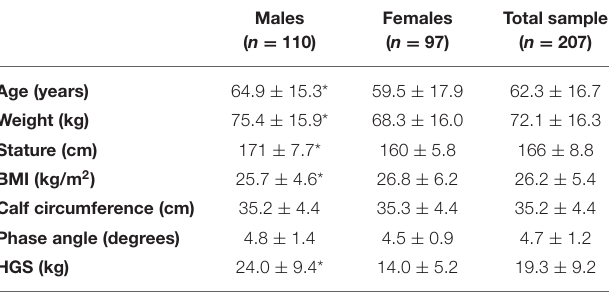
TABLE 1 | Anthropometric characteristics, body composition and handgrip strength in 207 patients.